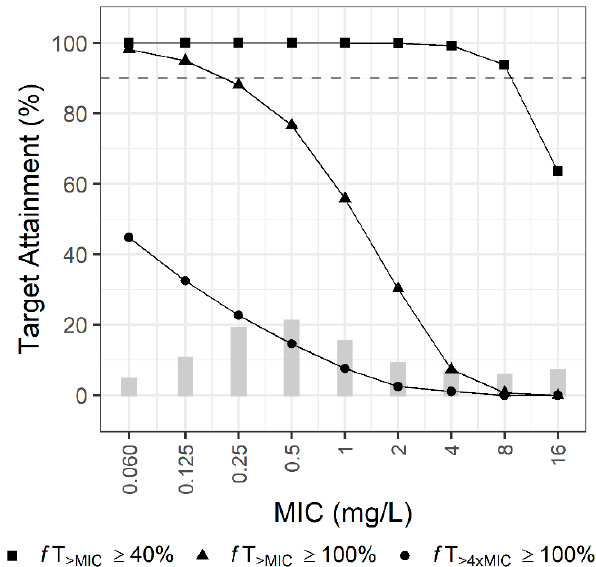
Figure 3. Probabilities of target attainment (PTA) of empirical therapy using the current dosage regimen for patients with an eGFR of 0–130 mL/min/1.73 m 2 . Bars indicate the MIC distribution for regimen for patients with an eGFR of 0–130 mL/min/1.73m 2 . Bars indicate the MIC distribution for P. aeruginosa P. aeruginosa .